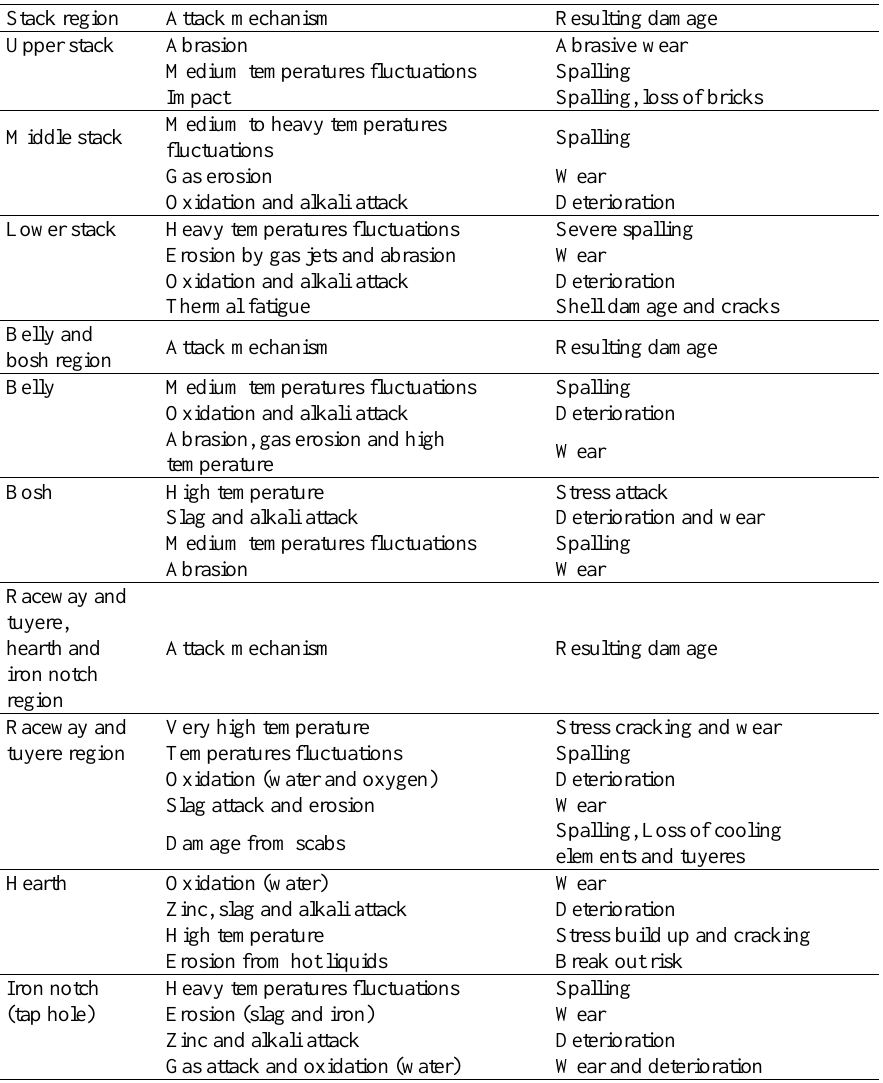
Table 1. Attack mechanisms in different regions of blast furnace [5, 10,